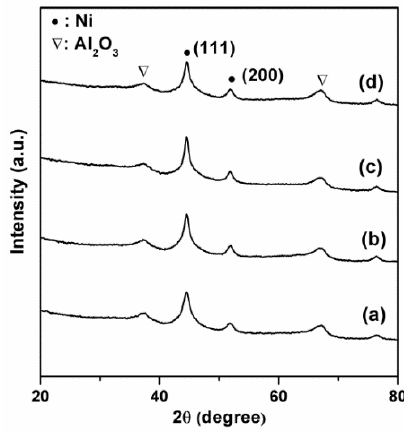
Figure 2. X-ray diffraction patterns of ( a ) 17.5% Ni/Al 2 O 3 -500, ( b ) 17.5% Ni-1.7% P/Al 2 O 3 -500, ( c ) 17.5% Ni-2.9% P/Al 2 O 3 -500, and ( d ) 17.5% Ni-4.4% P/Al 2 O 3